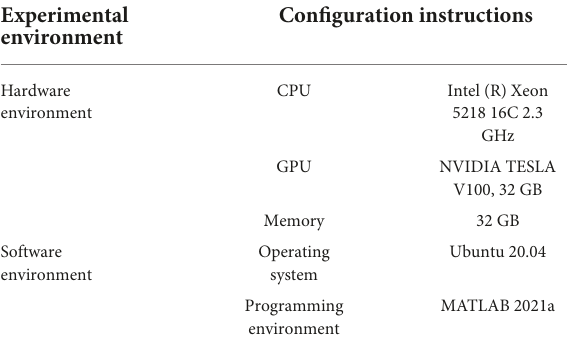
TABLE 1 Hardware and software